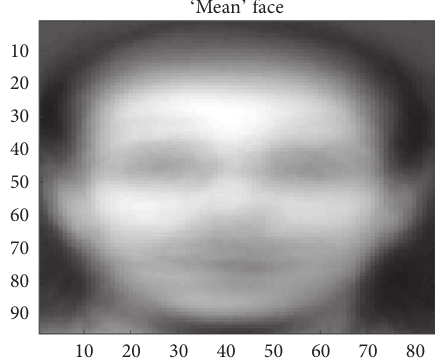
Figure 2: Mean face for the AT&T dataset.